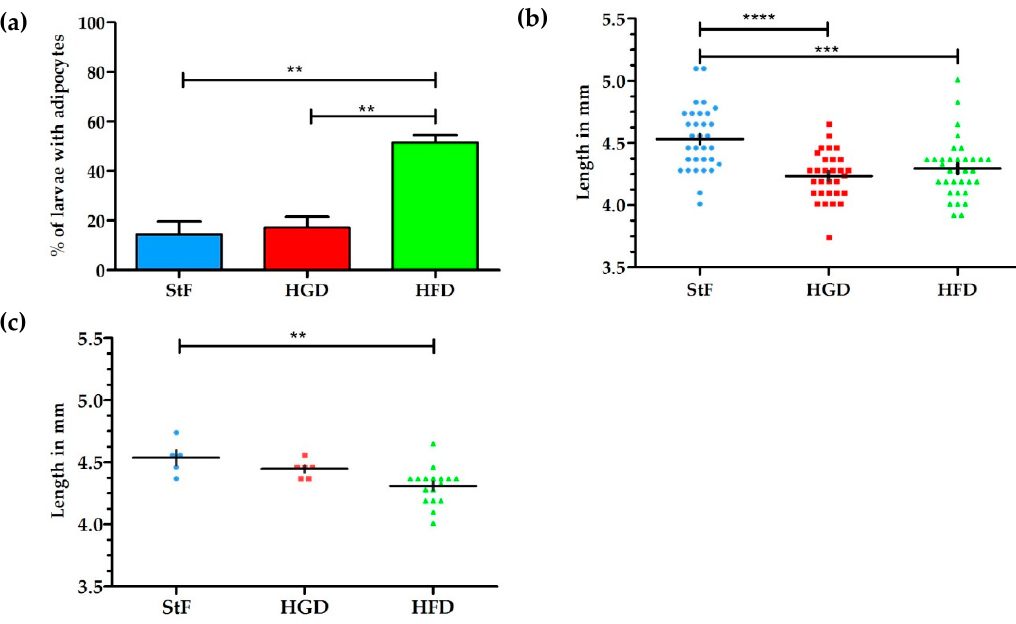
Figure 2. Effect of different diets on adipogenesis and growth of larvae. ( a ) Average percentage of larvae with adipocytes after feeding from 6–15 dpf with standard feed (StF), high glucose diet (HGD) or high fat diet (HFD); ( b ) Length (mm) distribution of larvae at 15 dpf. (StF: n = 32; HGD: n = 30; HFD: n = 33); ( c ) Length (mm) of larvae with adipocytes. (StF: n = 5; HGD: n = 6; HFD: n = 17) (** p ≤ 0.05, *** p ≤ 0.01, **** p ≤ 0.0001). Error bars represent Standard Deviation.